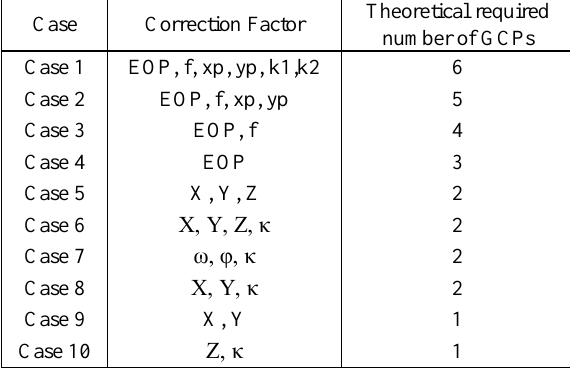
Table 3 Theoretical required number of GCPs per correction